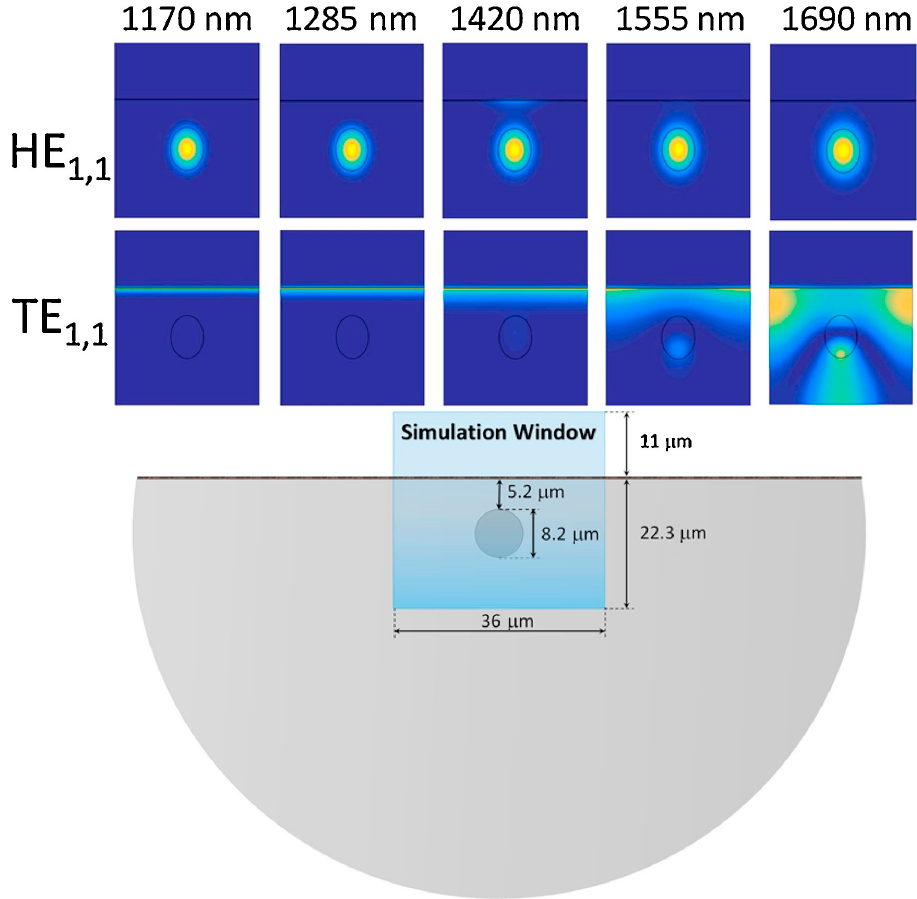
Figure 4. Schematic and simulation results of the electric field intensity in an indium tin oxide (ITO)-coated D-shaped fiber for the TE 1,1 and HE 1,1 modes. Reprinted from [16] with permission from Elsevier.